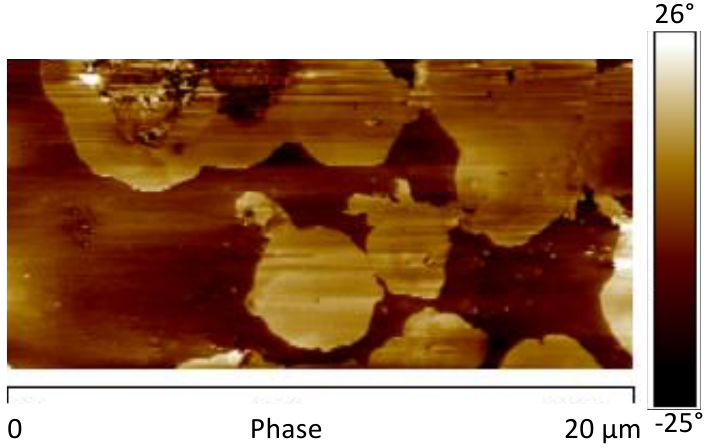
Figure 10. Atomic force microscopy (AFM) phase map image of the sample 0GNPs.